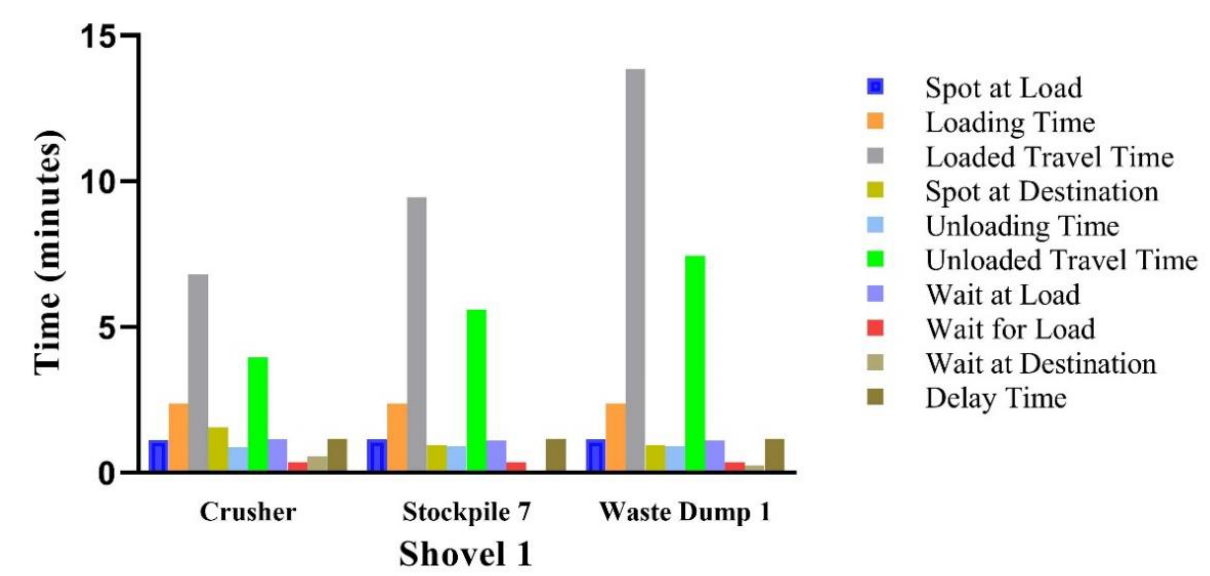
Figure 5. Total cycle time for trucks assigned to shovel 1.